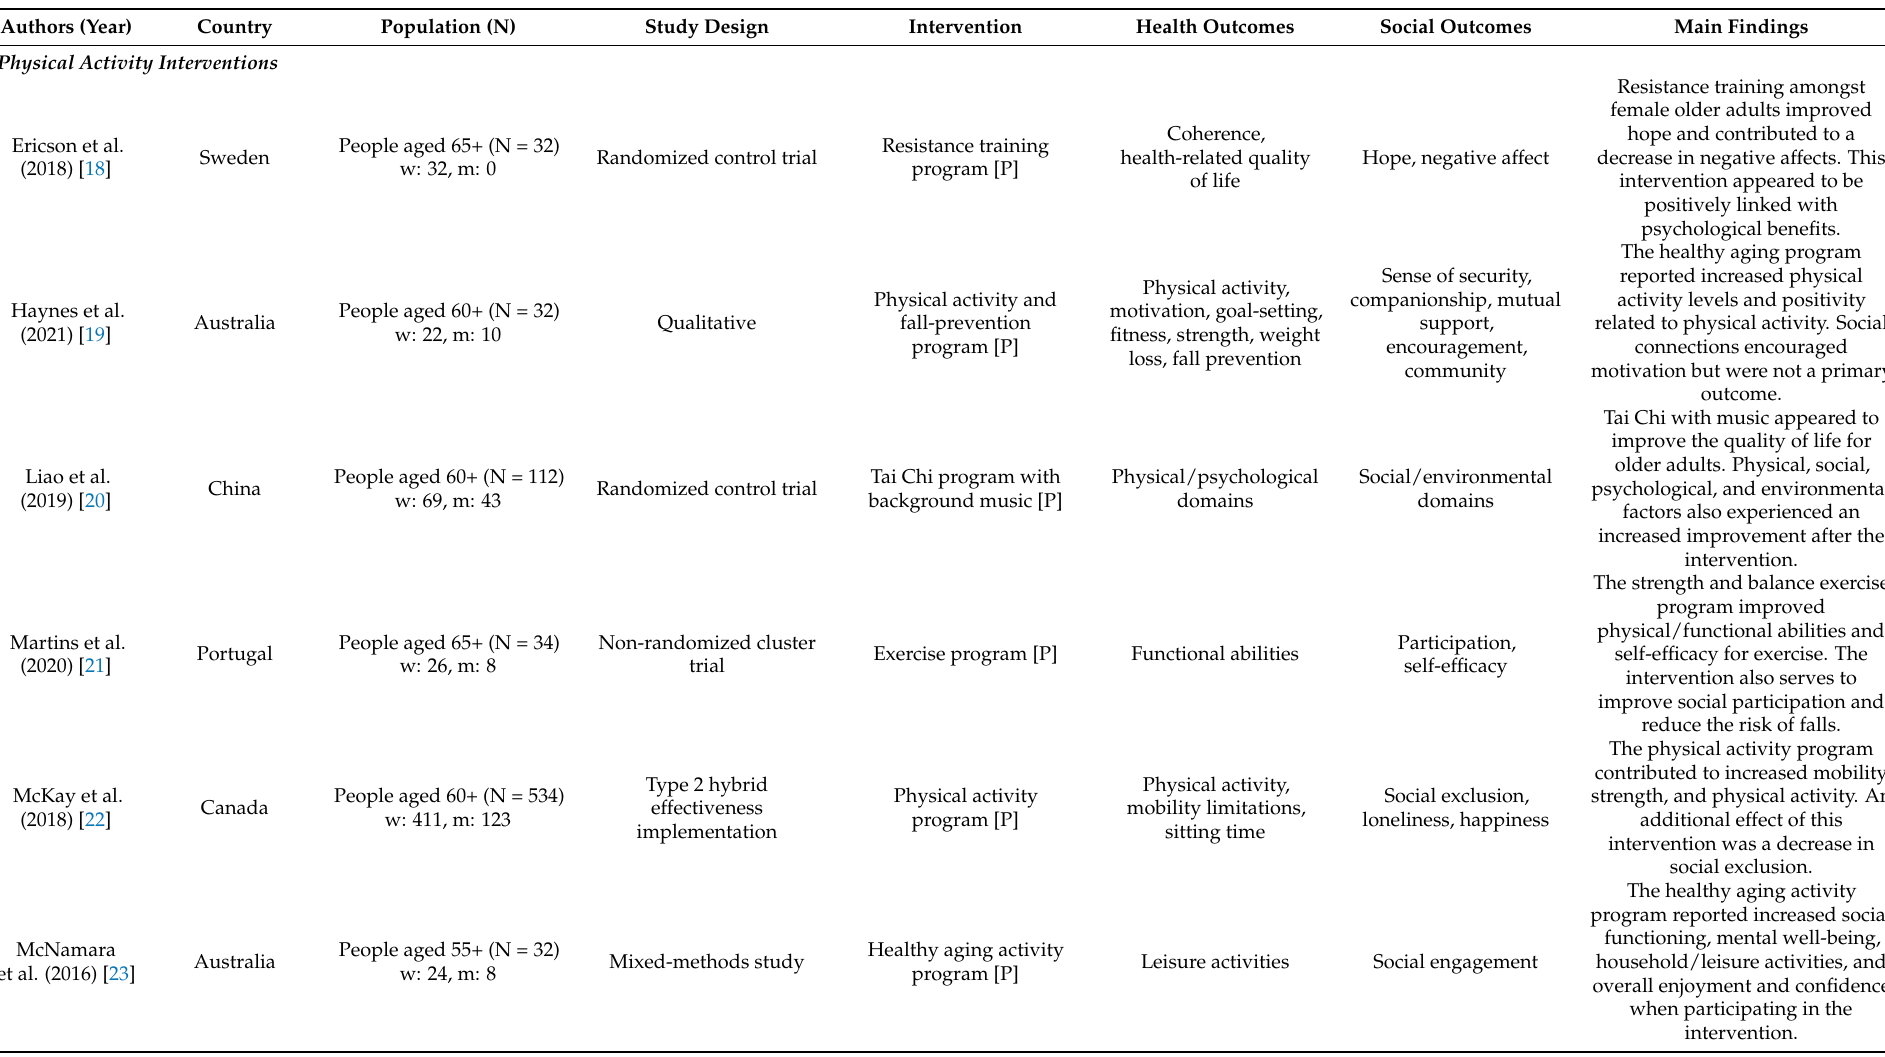
Table 3. Summary of the selected